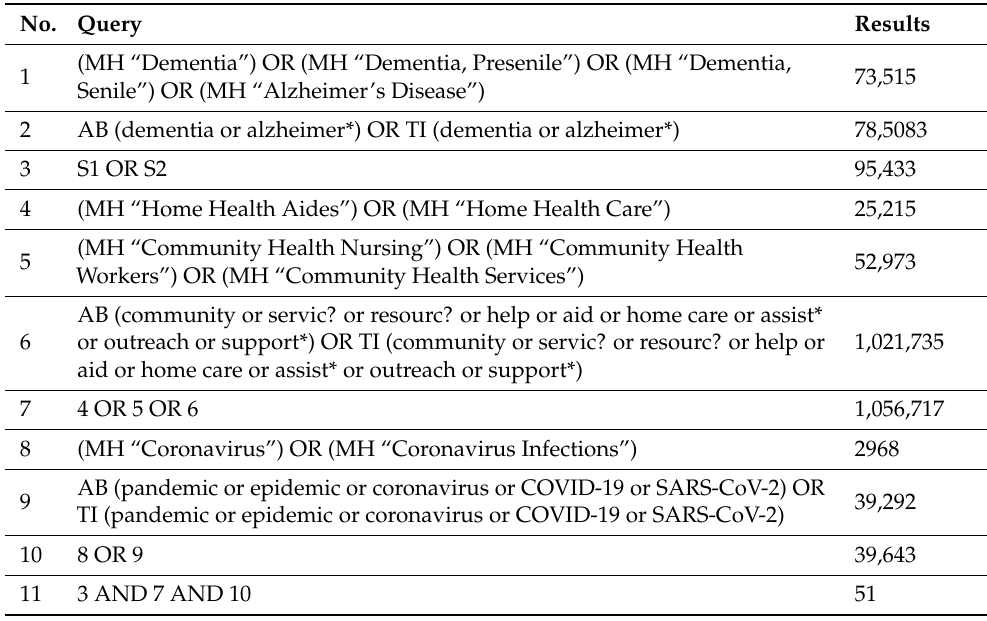
Table A3. CINAHL. Date of search: 7 July 2020.